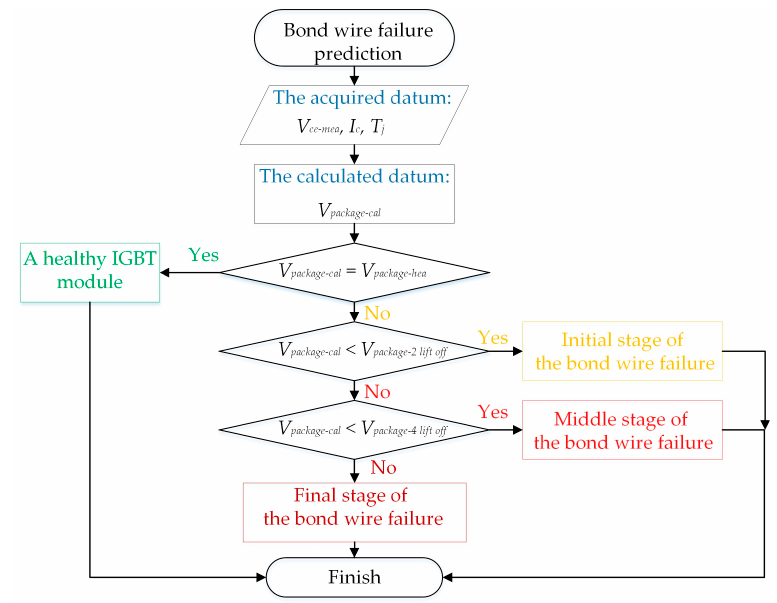
Figure 9. The method of applying on-state voltage separation strategy to bond wire failure prediction. Table 2. Different factors in the components of on-state voltage.